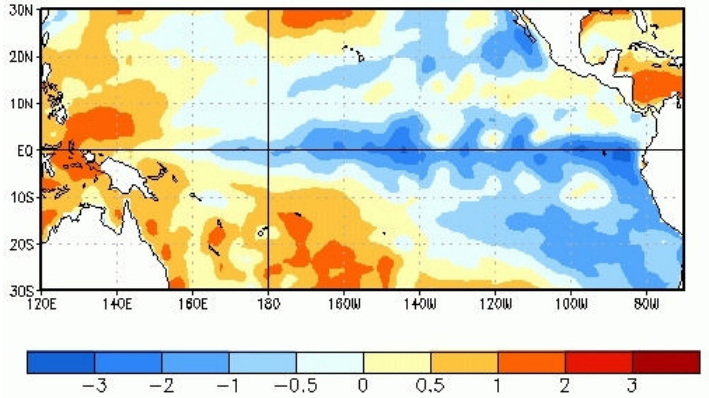
Fig. 8. Average SST anomalies for the week centered on 28 July 2010. Anomalies were computed with respect the 1971–2000 base period weekly means (Xue et al., 2003; http://www.cpc.ncep.noaa.gov/products/analysis monitoring/enso disc